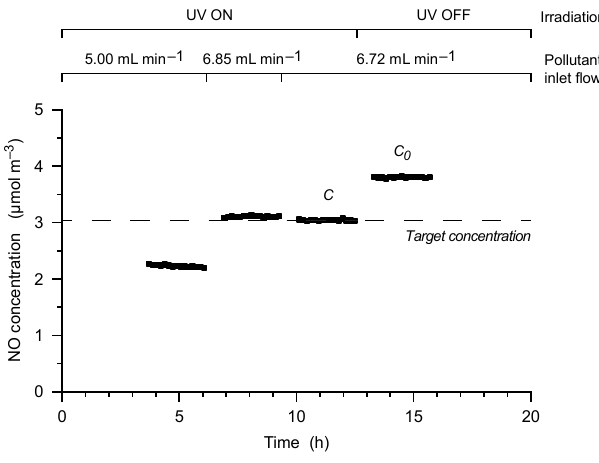
Figure 2. Catalytic activity measurement with the successive approximation process. At the third iteration the pollutant inlet flow required to reach the target concentration C is found; the UV source is then turned off, and the concentration C 0 is measured.